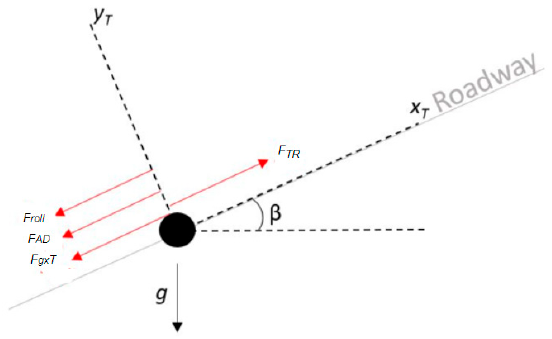
Figure 1. Free body diagram of forces acting on an EV. Adapted from [18], IEEE: 2020. The tire-road interaction of the vehicle and the traction properties of the tire-road interface are fundamental to the dynamics of a vehicle. The traction torque from the propulsion system is converted into a traction force through the interaction between the pneumatic tire and the road surface at the tire-road interface [17] illustrated in Figure 2. The speed of tire and the longitudinal speed of the vehicle vary in magnitude and direction and are a function of the forces acting on the tire, including the vertical load force that the vehicle body exerts on the wheel, F z , and the longitudinal forces exerted on the tire at the tire-road interface, F x . The rolling speed of the tire is related to the tire angular velocity and wheel radius r w and is given by Equation (6) [16]: